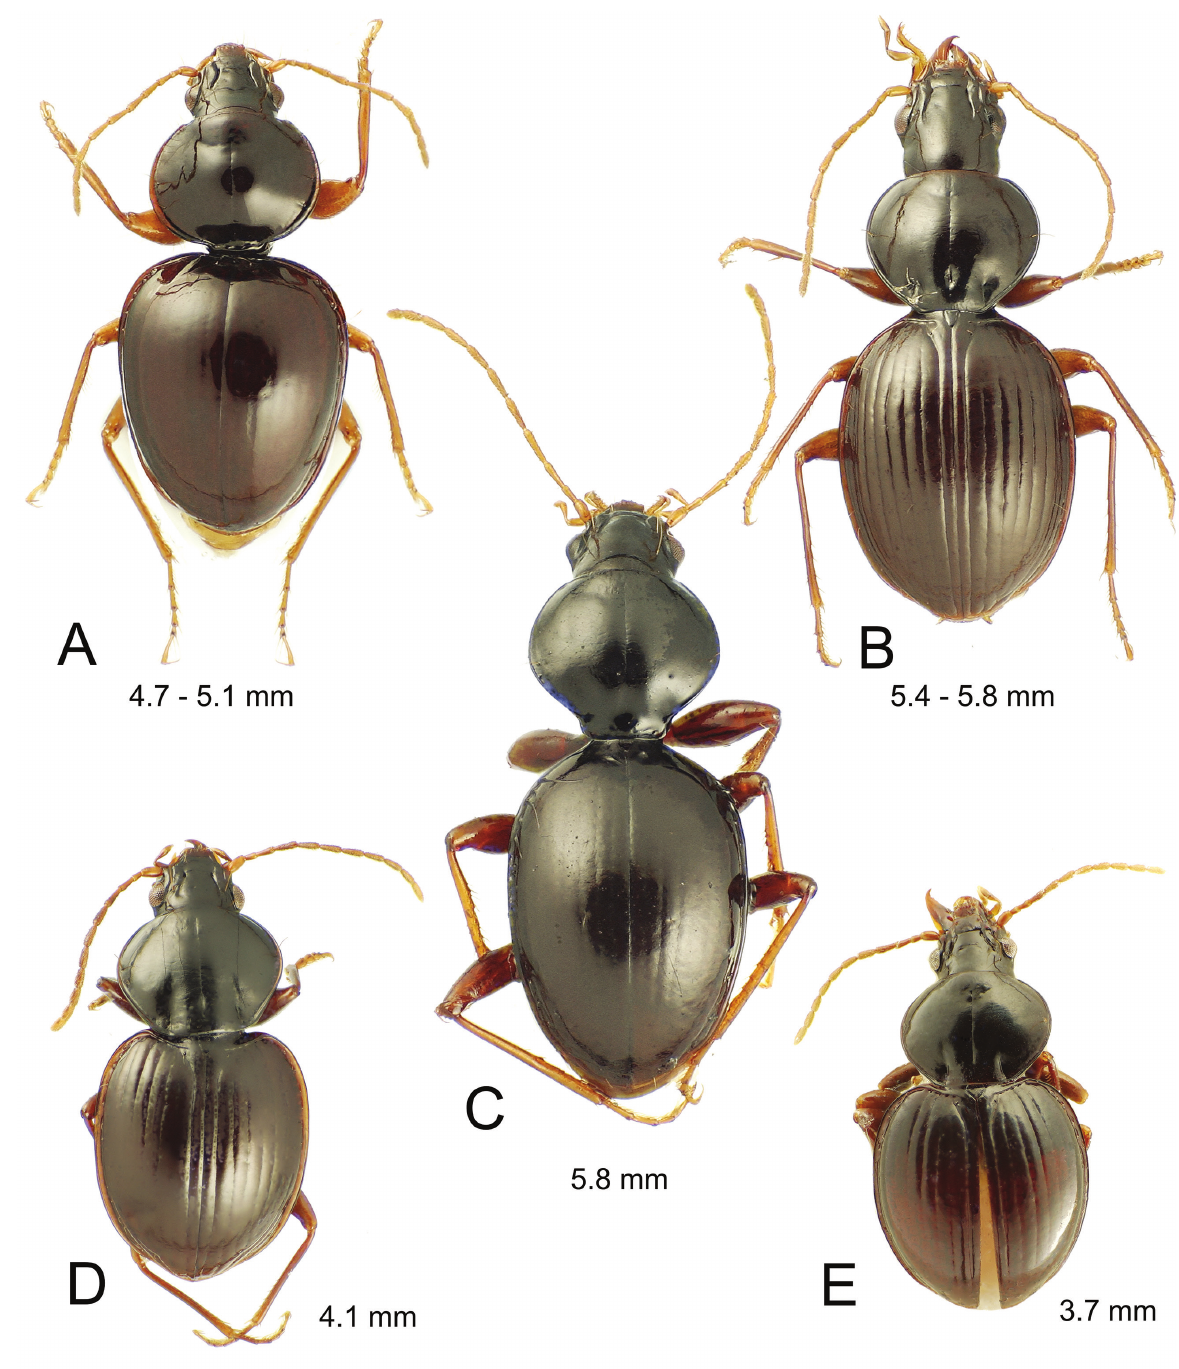
Figure 16. New Caledonian Mecyclothorax ( Phacothorax ) spp., dorsal view: A , M. plurisetosus ; B , M. megalovatulus ; C , M. octa- vius ; D , M. laterovatulus ; E , M. najtae